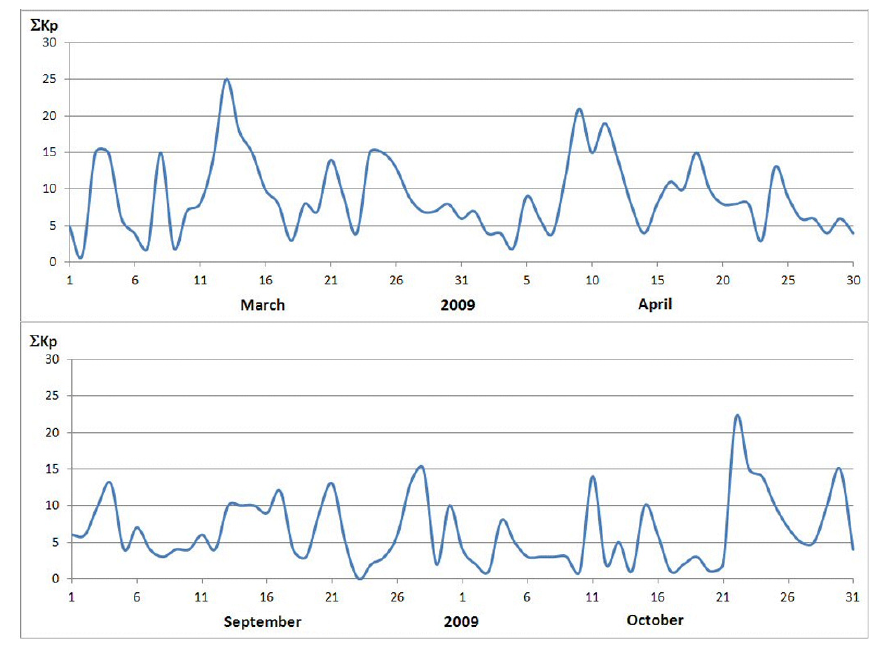
Fig. 2. Magnetic activity conditions in terms of P Kp for March, April, September, and October